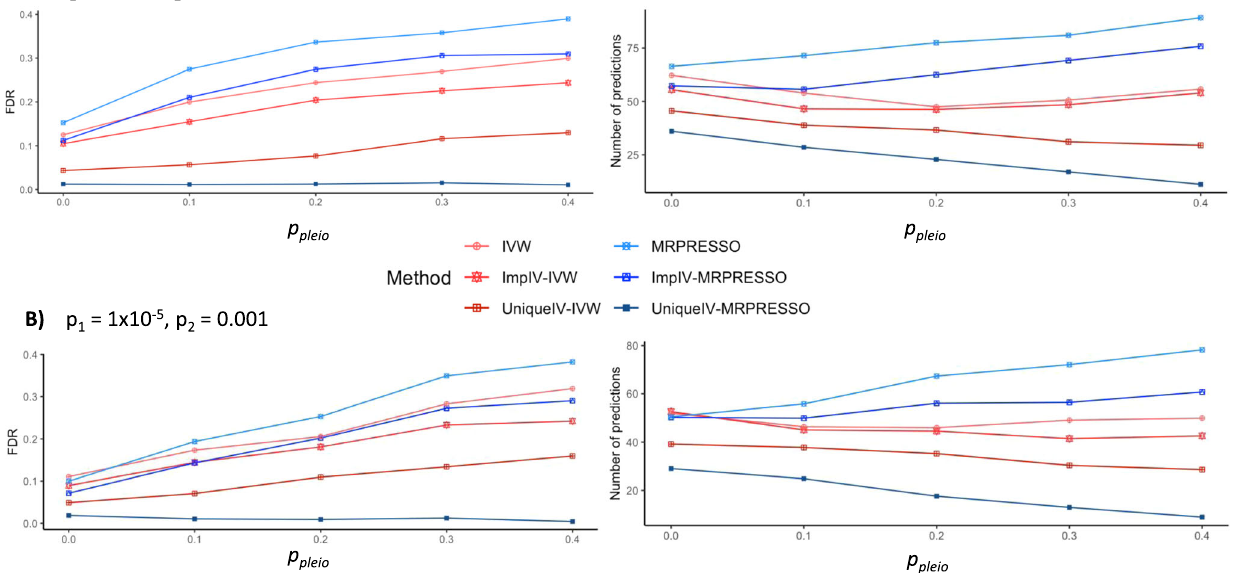
Fig. 3 Mean number of discoveries and empirical false discovery rates (FDR) of Mendelian randomization methods in simulated data from graphs with 15 continuous traits. The underlying causal diagram was generated such that the expected in- and out-going degrees of the traits were 1.5. All simulated graphs contained cycles. For each trait we added between 10 and 20 binary instruments (uniformly, i.i.d). To add horizontal pleiotropy, for each instrument we decided whether it is horizontally pleiotropic or not with probability p pleio , and if so, we added between 1 and 10 links into additional traits (uniformly, iid). When generating datasets, the traits had standard normal noise, causal quantities were randomly and uniformly sampled such that their absolute value was between 0.1 and 0.9, and binary instruments were generated randomly with a probability between 0.05 and 0.4. The plots show the mean results of the simulations for different p pleio values (e.g., the mean of the empirical FDR over the simulated graphs). Discoveries from each statistical test were done at a 10% signi fi cance level after adjusting for FDR using the BY algorithm. When two methods have a similar empirical FDR, greater number of predictions correspond to greater power. a Results with p 1 = 0.001 and p 2 = 0.01. b Results with p 1 = 1 × 10 − 05 and p 2 = 0.001. MR-Egger is not presented as it consistently had greater empirical FDR values than the other